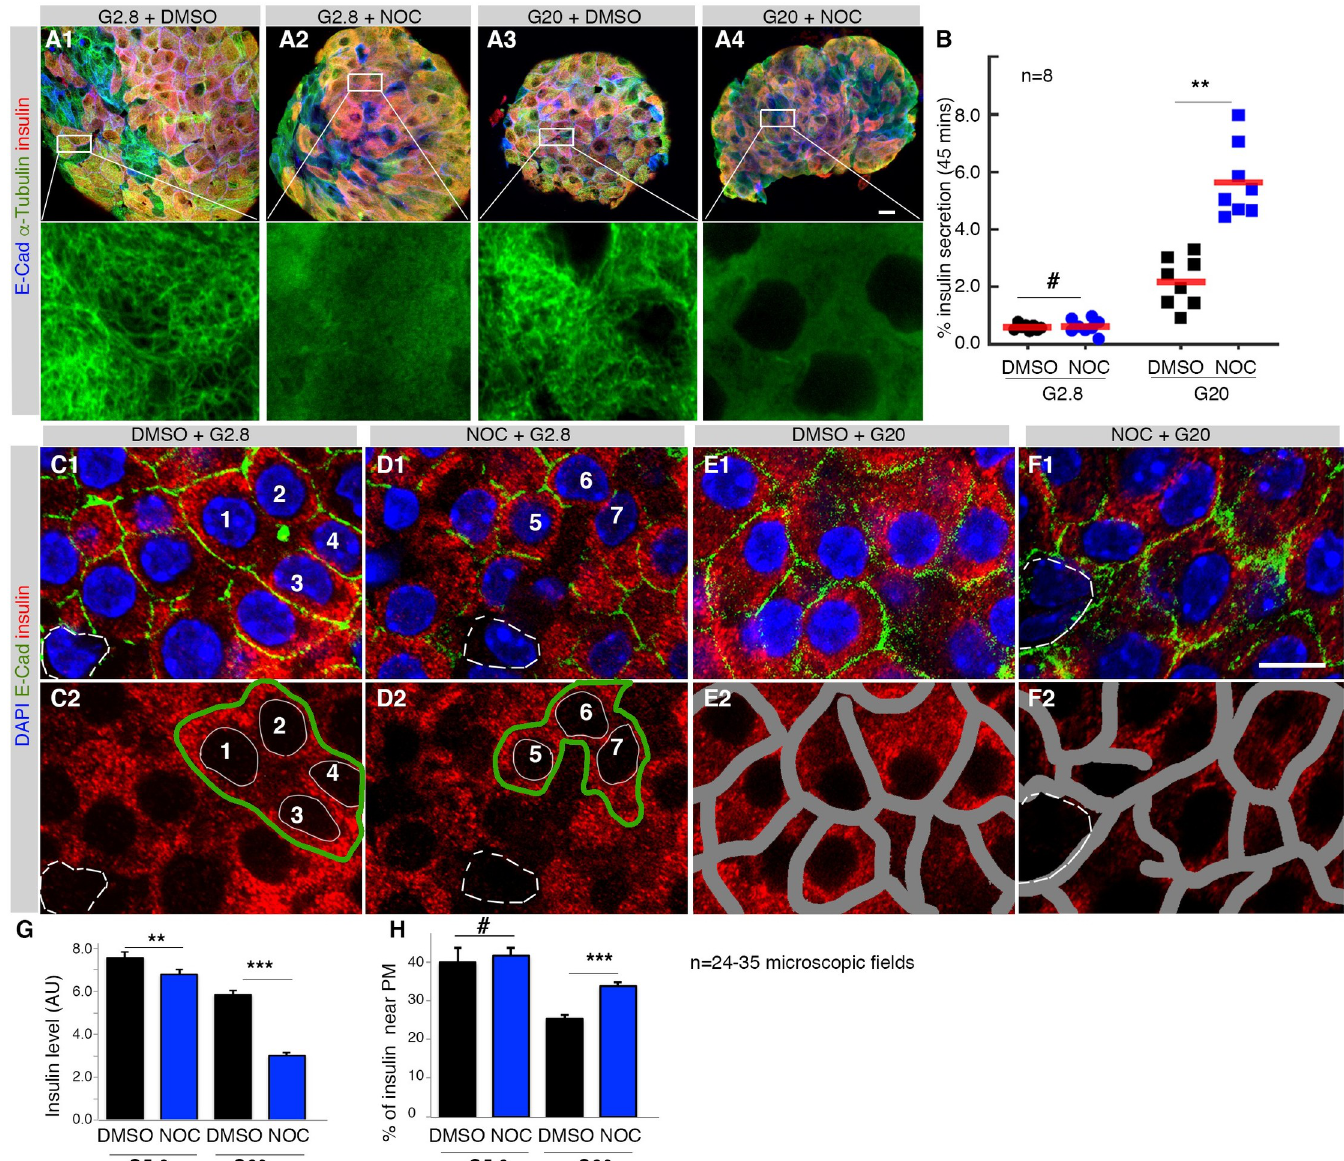
Fig 1. MTs are dispensable for insulin SGs localization near β -cell periphery. (A) MT-destabilization by NOC-treatment [A1, 2.8 mM glucose (G2.8) plus DMSO; A2, G2.8 + NOC; A3, (G20 + DMSO); A4, (G20 + NOC)]. Images shown on the top row are maxi-projections of whole mount stained islets, showing co-staining of insulin (red), E-cadherin (E-Cad, blue), and α -tubulin (green). The bottom row includes high-magnification of boxed areas of the top panels, highlighting MT-destruction by NOC. (B) GSIS in islets treated with NOC for 12-hours, scatter plots with mean shown. (C-F) Insulin–subcellular localization (red) in β cells. In (C1-F1), DAPI and Ecadherin signals locate nuclei and cell membrane. A few Ins-negative cells were marked in C, D, and F (white broken circles). (C2, D2) The scheme to assay relative insulin levels in β cells: clusters of β cells showing clear nuclear signals were selected [green circles in C2 (cells 1–4), D2 (cells 5–7)] after excluding the nuclear areas, white circle. (E2, F2) The scheme to examine subcellular insulin localization. Β -cell zones along the PM ( ± 1 micrometer, grey bands) were marked and the portion of insulin signals that localize within these zones were determined. (G, H) Relative insulin levels and the portions of insulin that localized near PM, shown as mean + SEM. In (B), (G), (H), #: p > 0.12, �� : p < 0.01, ��� : p < 0.001, calculated using multi-comparison ANOVA. Please refer to S1 Table for original numbers used in